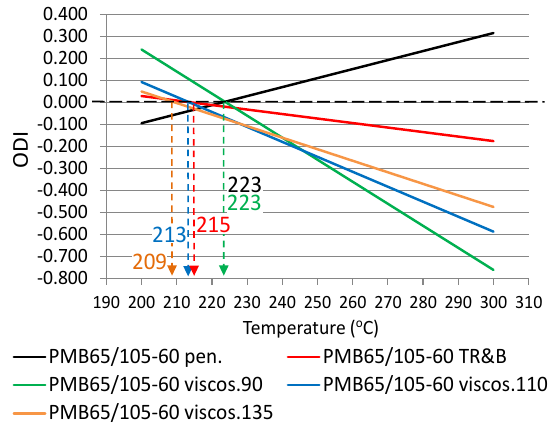
Figure 5. Overheating Degradation Index for binder 20/30 and determination of temperature T (ODI) .